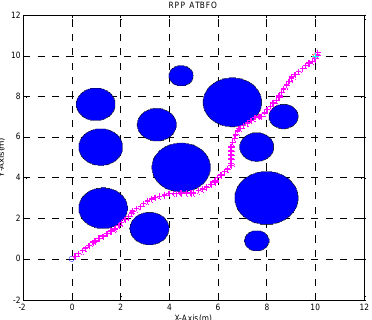
Fig. 11. Best shortest path for case 2(2nd test).